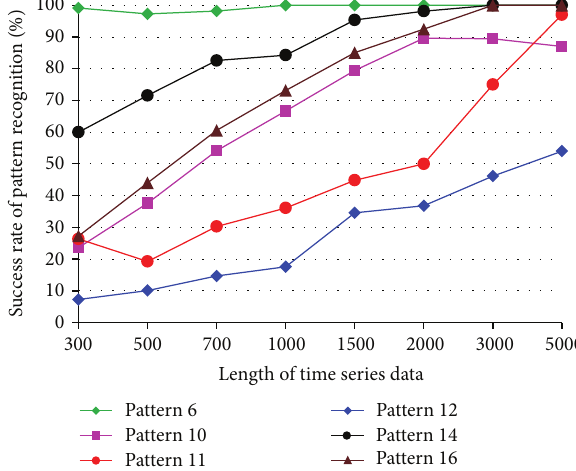
Figure 19: Success rate of pattern recognition using DWT-based feature extraction in second scenario (sensor